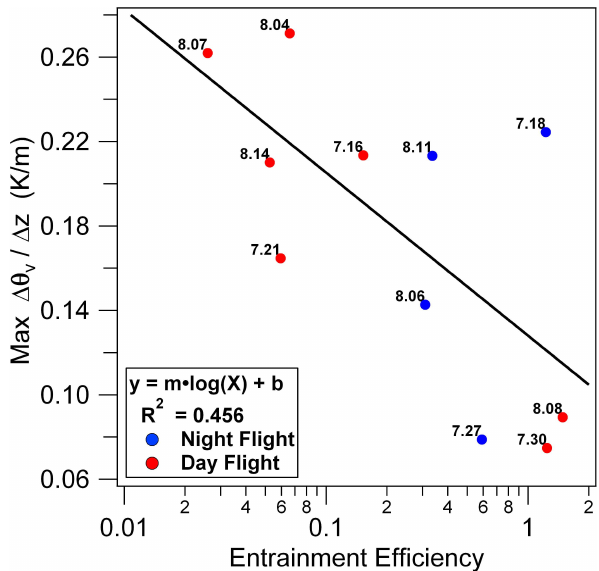
Fig. 10. Scatter plot of the entrainment efficiency η versus the max- imum θ v gradient, which is a measure of the stable stratification of the air in the cloud top region. Each point is the average value for the flight, with the corresponding date beside each point, and color denoting day and night